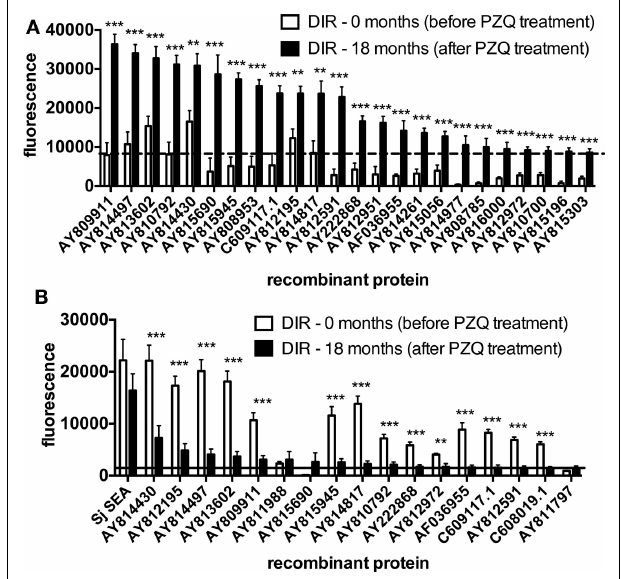
FIGURE 2 | Antibody responses to arrayed antigens differ in Schistosoma haematobium -infected humans before and after praziquantel treatment . (A) IgG1. (B) IgE. Average adjusted signal intensity values depicting the antibody response to each reactive antigen are shown for the drug-induced resistant (DIR) cohort before and after praziquantel treatment. The dashed and solid lines are the respective cut-offs for IgG1 (8239) and IgE (1861) reactivity, calculated as one standard deviation of the mean of the no-DNA control spots on the array. Statistical analysis was performed using Student’s t -test. * p < 0.05, ** p < 0.01, *** p <